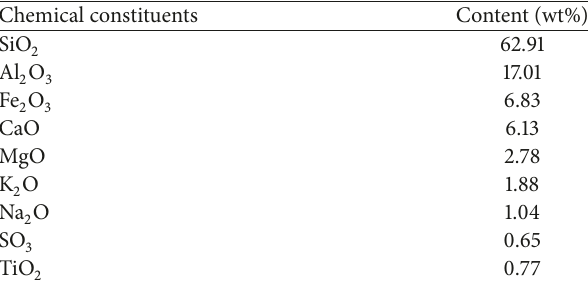
Table 1: Chemical composition of